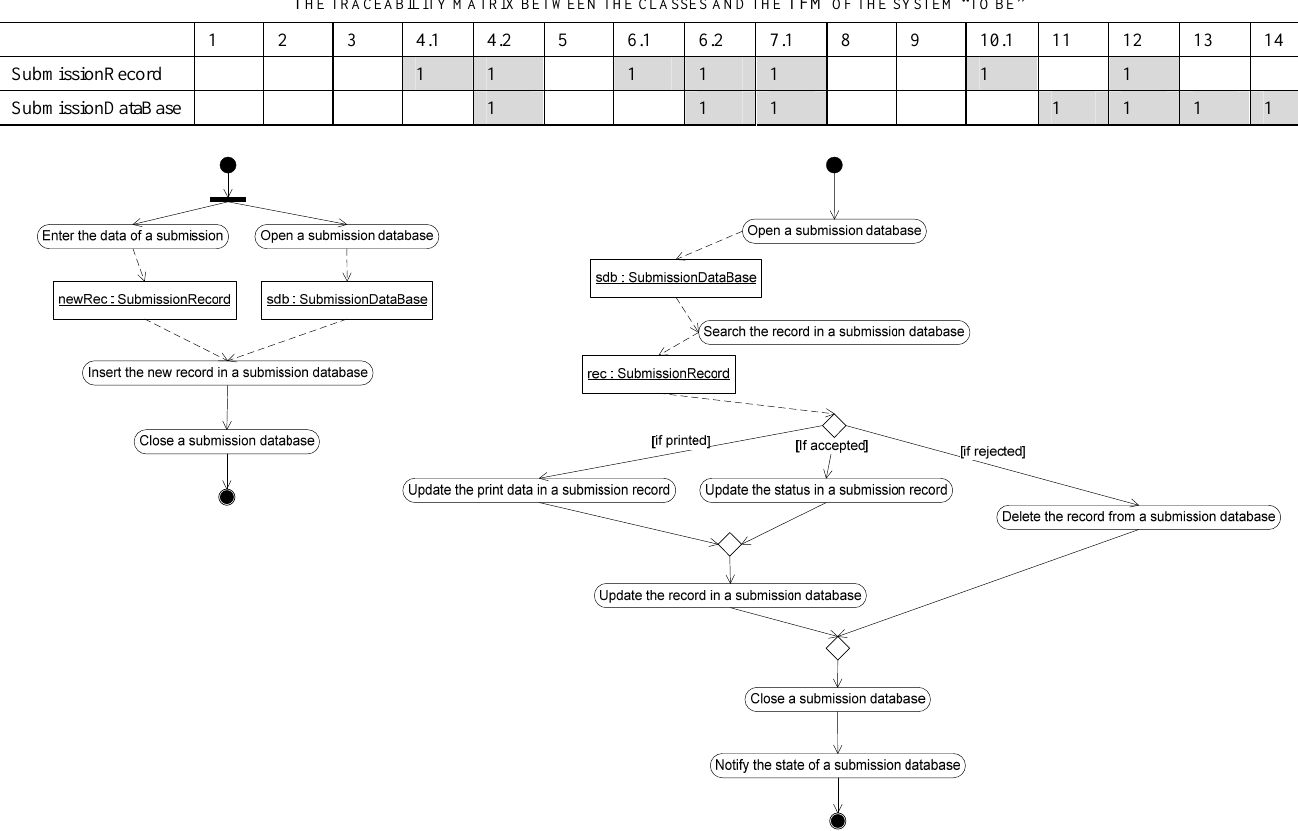
Fig. 5. Behavior diagrams (UML Activity diagrams) created in conformity with the TFM of the system “to